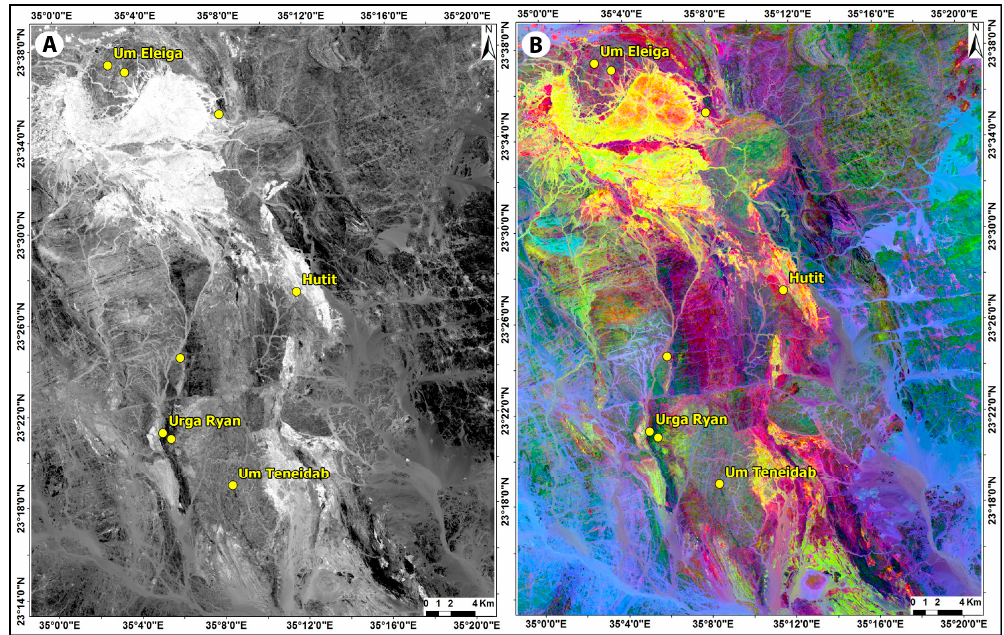
Figure 4. Spectral discrimination of ophiolitic rocks by a processed Landsat-8 OLI scene of the study area. ( A ) Grayscale band ratio (6/7) image; ( B ) false color composite (FCC) band ratio image (red (R): 6/7, green (G): 6/5, blue (B): 4/2) of the study area. The ophiolitic rocks are highlighted by yellow or lemon-yellow pixels and clearly display signs of shearing and dislocation. Note that the ophiolitic rocks are rather abundant along the eastern shear zone which accommodates the Hutit mine. The yellow-filled circles are gold occurrences and/or locations of old gold mines as in the geological map (Figure 2).